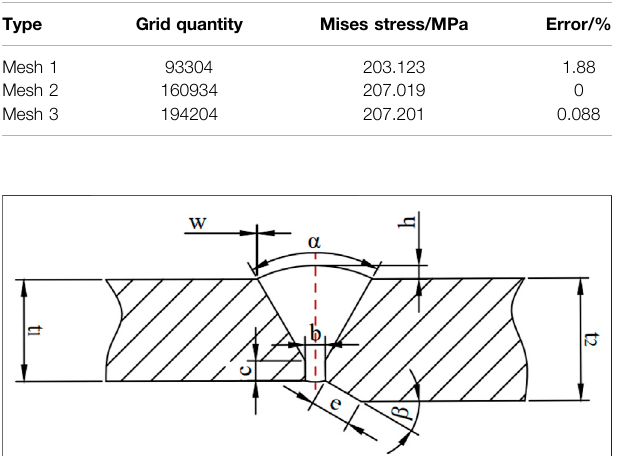
TABLE 5 | Grid independence veri fi cation.